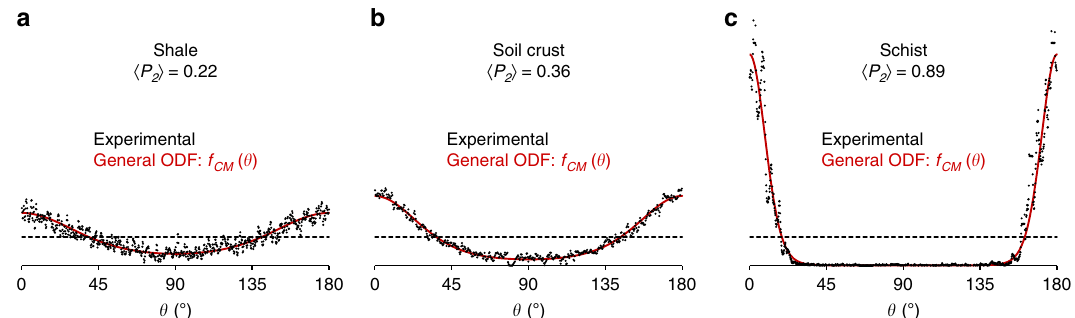
Fig. 6 Application of the general orientation distribution function for natural clay-rich media. Experimental and best- fi tted ODFs using the general f CM ( θ ) ODF for clay minerals ( f CM ( θ ) using Eq. (21)) are shown as circles and red lines, respectively. The anisotropy in particle orientation described by the 〈 P 2 〉 order parameter is extracted from the calculated f CM ( θ ) functions. The samples are displayed with a gradual increase in anisotropy value with a a shale from Paris Basin with 〈 P 2 〉 = 0.22, b a soil crust from the Versailles experimental site with 〈 P 2 〉 = 0.36, and c a schist from the Armorican Hercynian belt with 〈 P 2 〉 = 0.89. Isotropic organization is shown as a horizontal dotted line for reference.